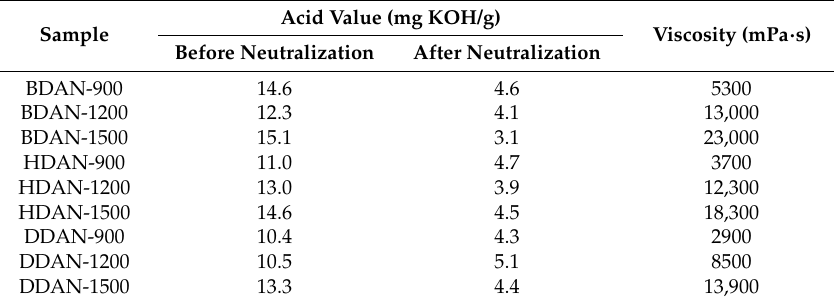
Table 4. Acid value and viscosity of oligolactide